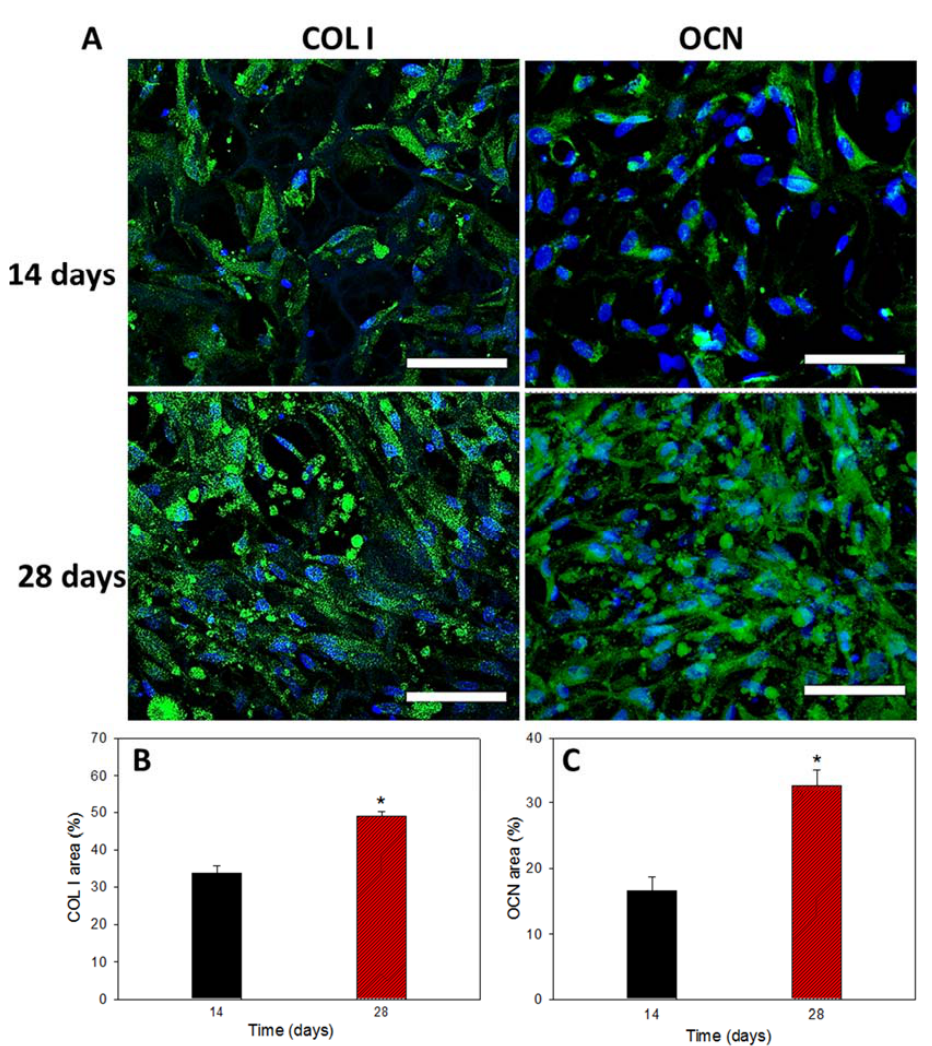
Figure 12. Immunofluorescent staining images using DAPI for cell nucleus and FITC ‐ conjugated antibody for type I collagen (COL I) and osteocalcin (OCN) ( A ) (bar = 300 μ m). The semi ‐ quantitative analysis of COL I ( B ) and OCN ( C ) were obtained by analysis with PAX ‐ it! TM software. * p < 0.05 compared to day 14. Bar = 75 μ m.